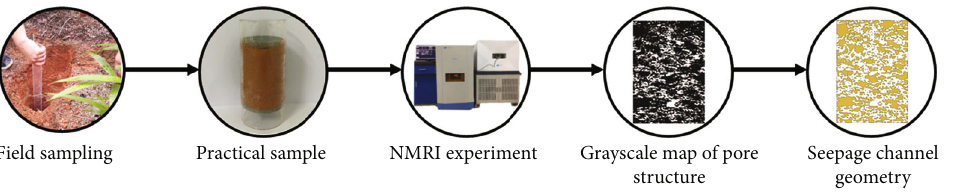
Figure 2: Construction steps of the NMRI model.